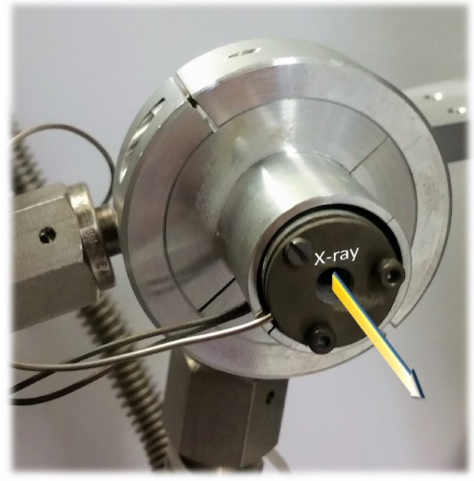
Figure 6. SAXS furnace with a 4 mm